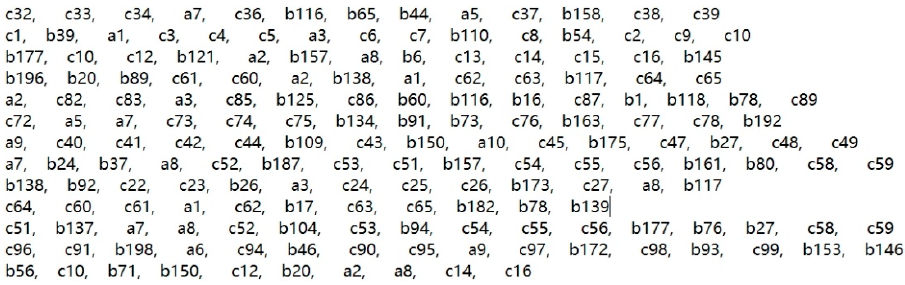
Figure 8. A fragment of the first type of data. Each row denotes a pattern session.